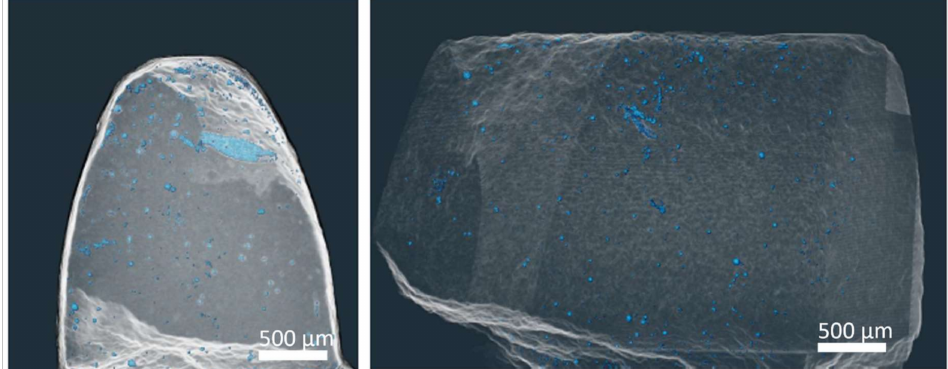
Figure 10. 3D models of computer tomography of the gear wheel